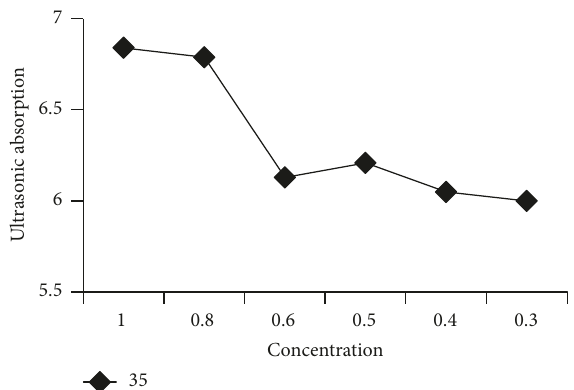
Figure 5: Variation of acoustic impedance with concentration at 35 ∘ C temperature.